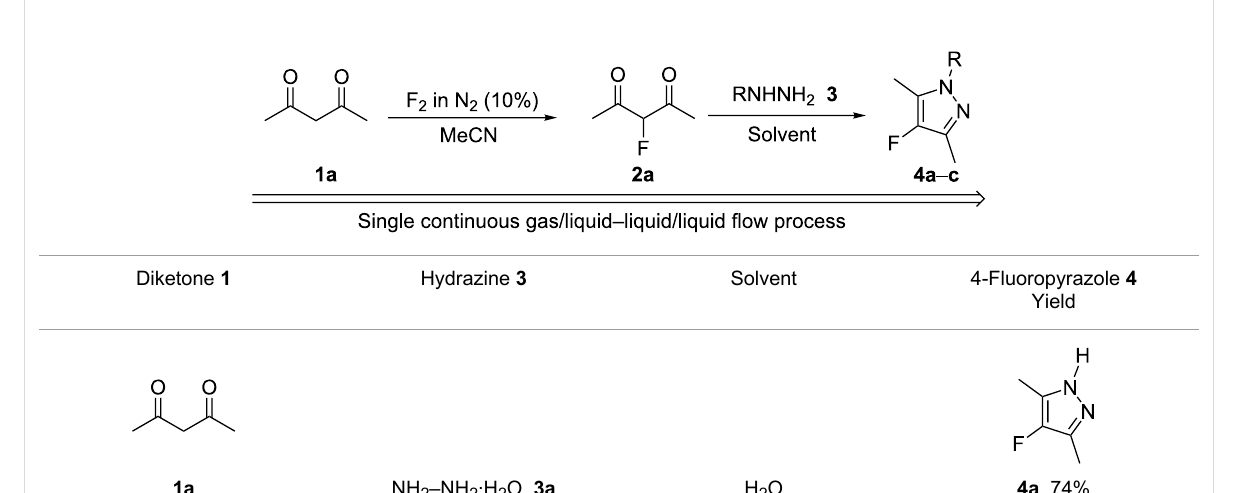
Table 1: Synthesis of 4-fluoro-3,5-dimethylpyrazole